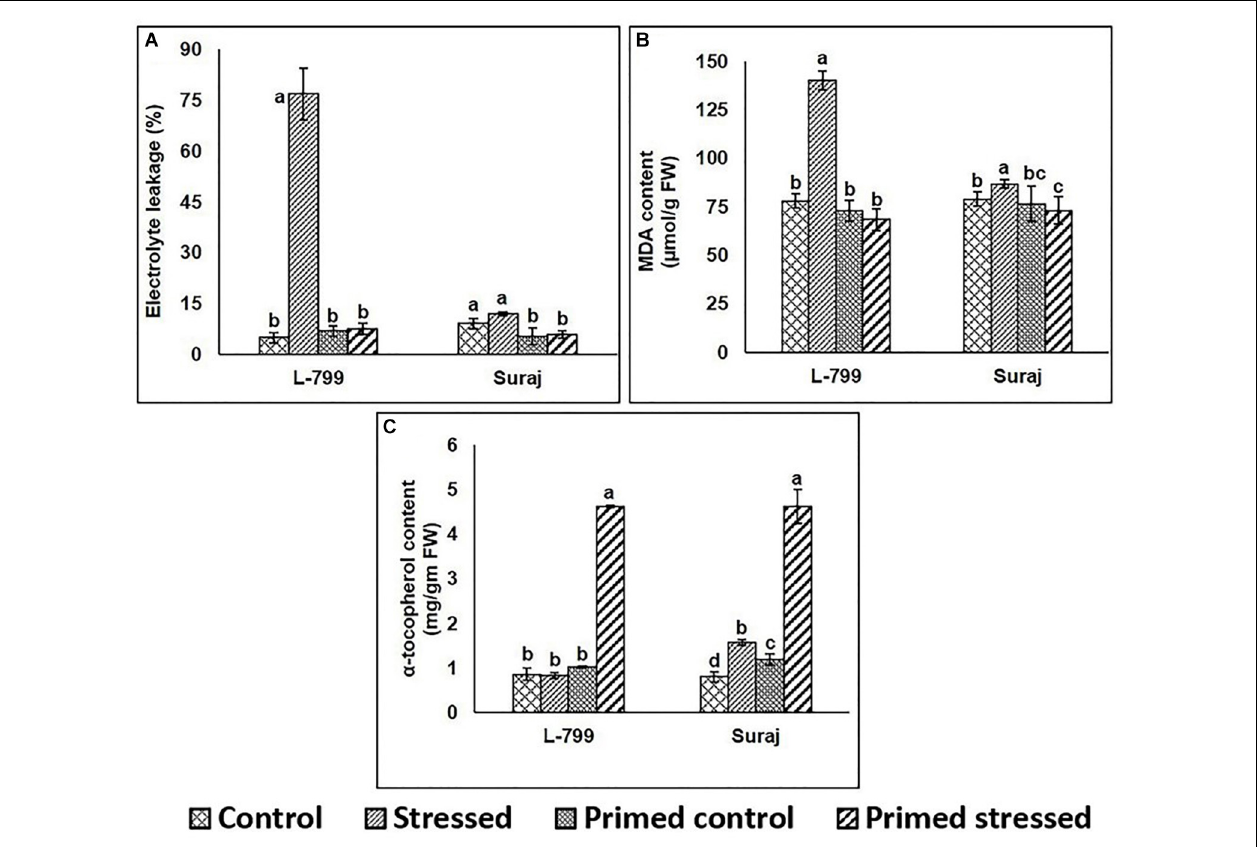
FIGURE 6 | Effect of melatonin priming on electrolyte leakage, lipid peroxidation, and α -tocopherol contents in drought-tolerant and -sensitive varieties with or without drought stress. (A) Electrolyte leakage, (B) lipid peroxidation, and (C) α -tocopherol contents in leaves of different treatments. Data represent mean values ± SD of minimum 3 independent experiments. Different alphabets within the group represent significant differences among treatments according to Duncan multiple range test at P <